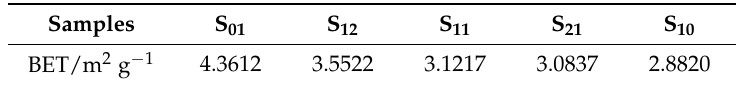
Figure 5. TEM ( a ) and high-resolution TEM ( b ) of S 12 .